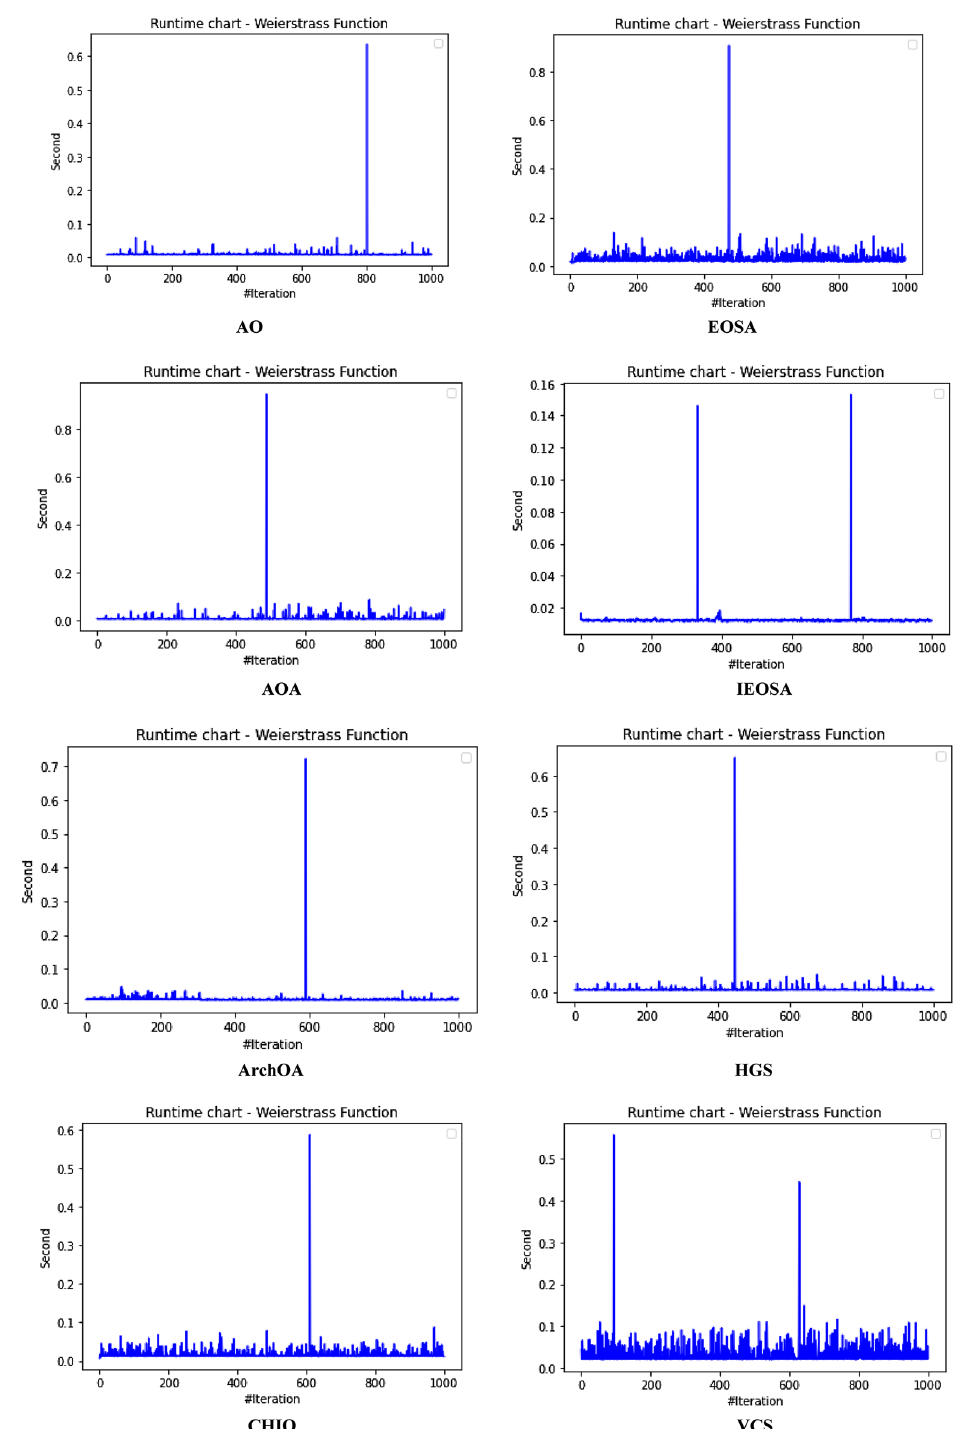
Figure 8. Performance evaluation of the runtime in running generalized penalized function (F4) for IEOSA, comparatively with AO, EOSA, AOA, IEOSA, ArchOA, HGS, CHIO, VCS, GA, and